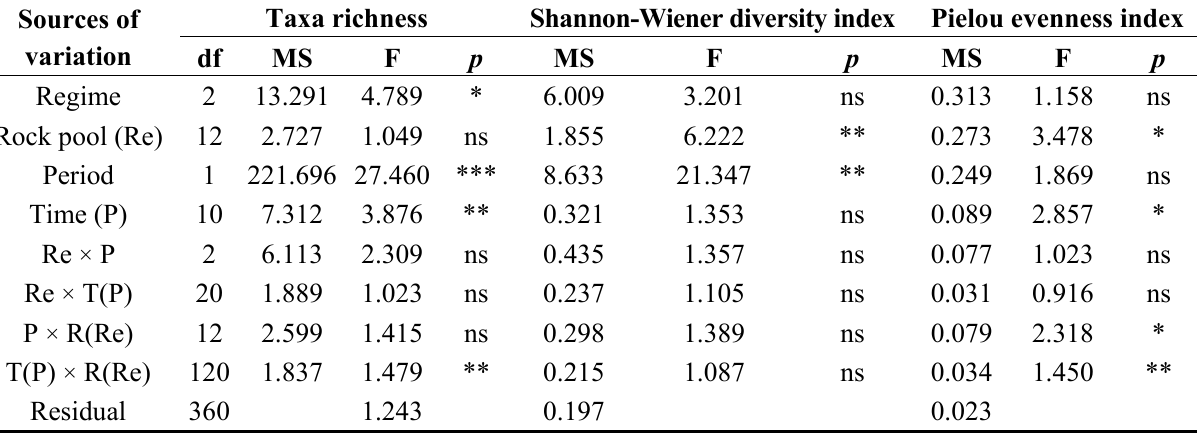
Table 2. Univariate analysis performed with a four-way partially hierarchical ANOVA for differences in taxa richness, Shannon-Wiener diversity index and Pielou evenness index among regimes, rock pools, periods and times through nutrient enrichment